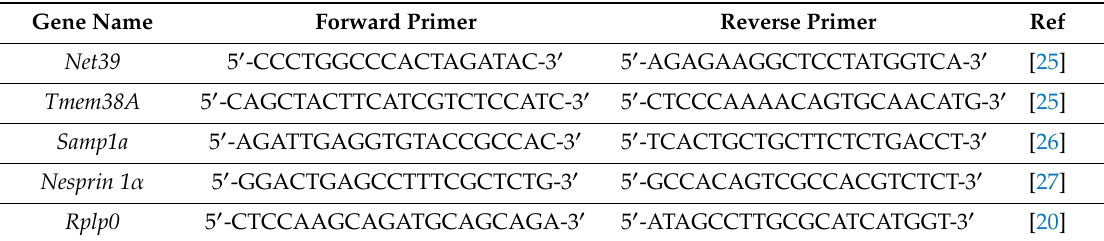
Table 2. List of primers used for quantitative